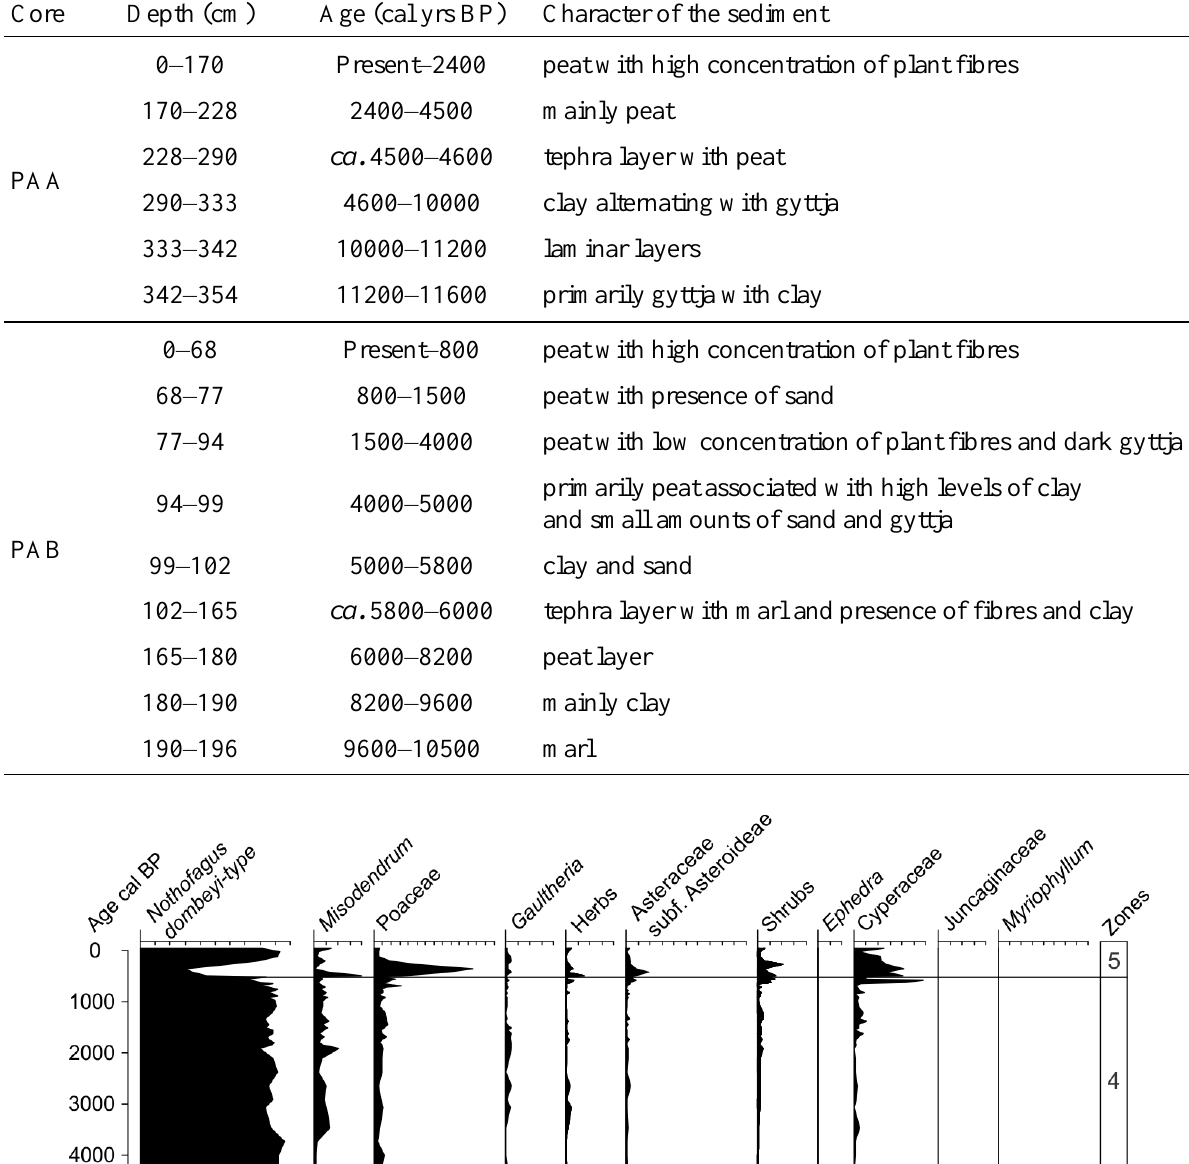
Table 2. Sediment descriptions for the PAA and PAB peat cores.